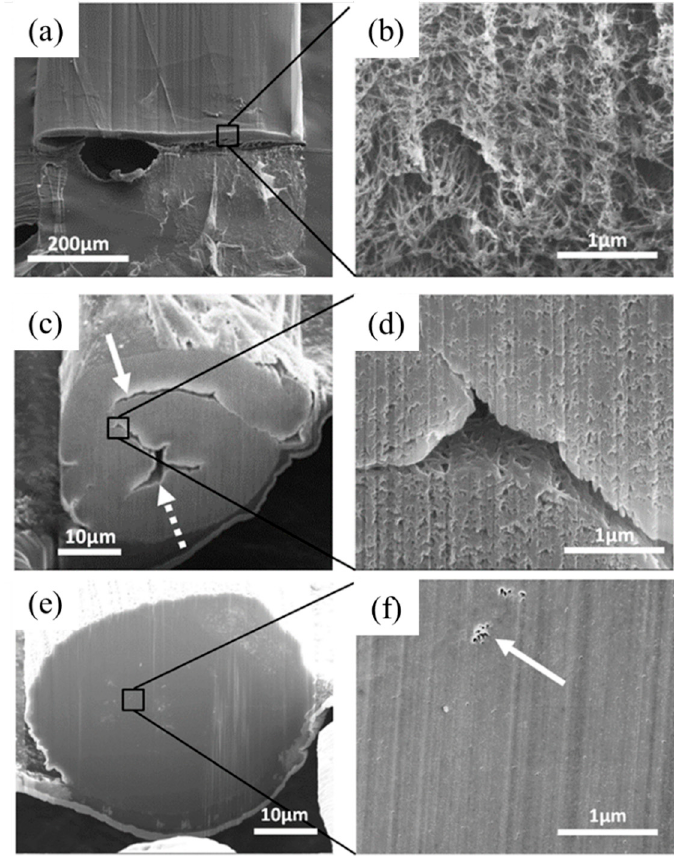
Figure 5. Cross-section view of scanning electron microscopy (SEM) images of different CNT yarns. ( a ) Untwisted CNT ribbon (as-received material). ( b ) High magnification revealing universal porosity. ( c ) Twisted yarn with folded structure (solid arrow) and large voids (dotted arrow). ( d ) High magnification revealing improved packing and limited micro-porosity. ( e ) DCPD-infused and consolidated CNT yarn. ( f ) Entirely solid structure with very limited nano-scale pores (solid arrow).